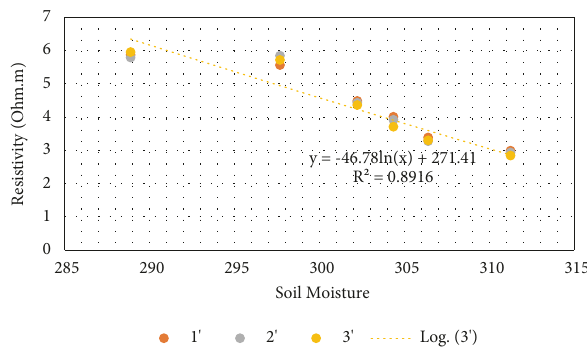
Figure 7: Summarize resistivity data from Line 1 until Line 6 vs soil